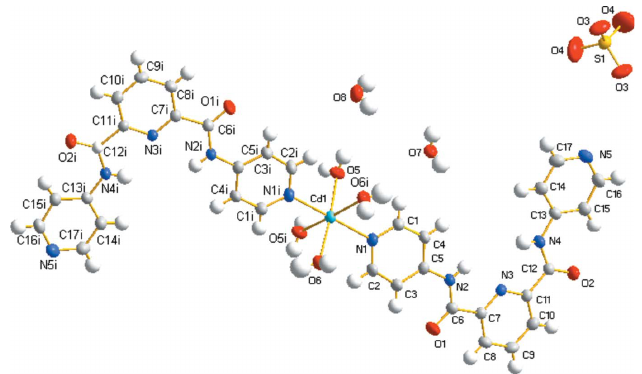
Figure 2 The molecular structure of the title complex (II) with displacement ellipsoids shown at the 50% probability level. Symmetry code: (i) (cid:5) x , y , (cid:5) z + 1 . 2